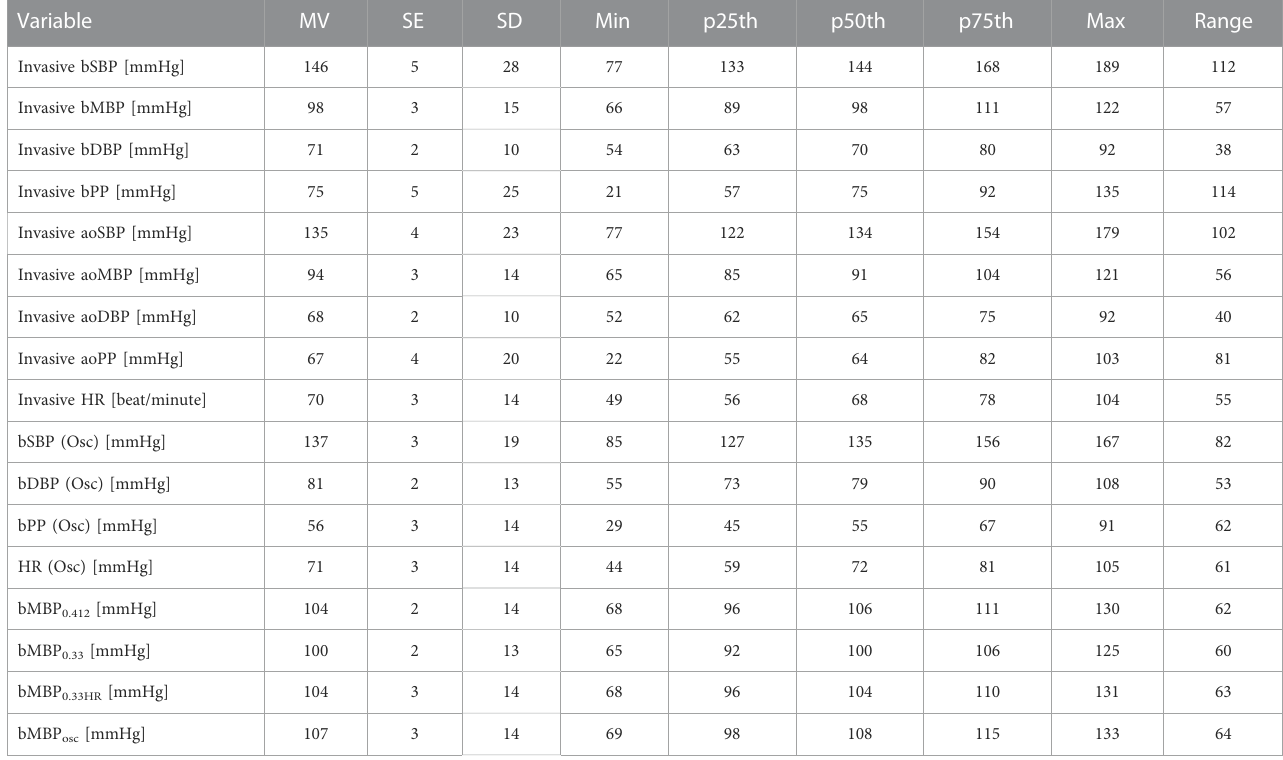
TABLE 2 Invasive aortic, and invasive and non-invasive (oscillometry) brachial pressure levels.